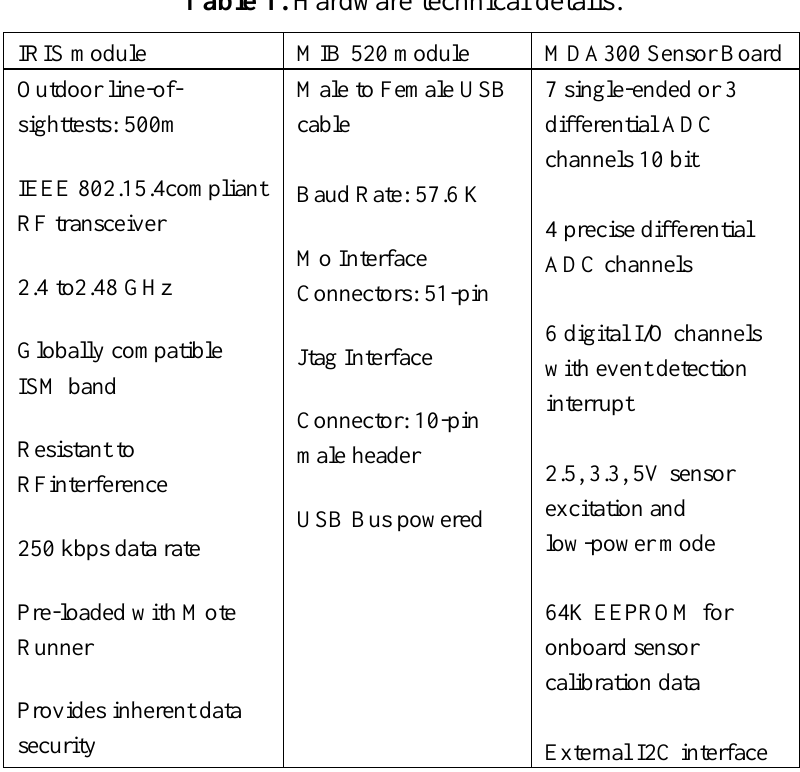
Table 1. Hardware technical